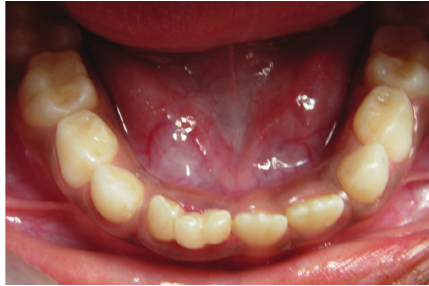
Figure 2: Image of lower arch showing triple teeth on right side and permanent central and lateral incisors on left side.